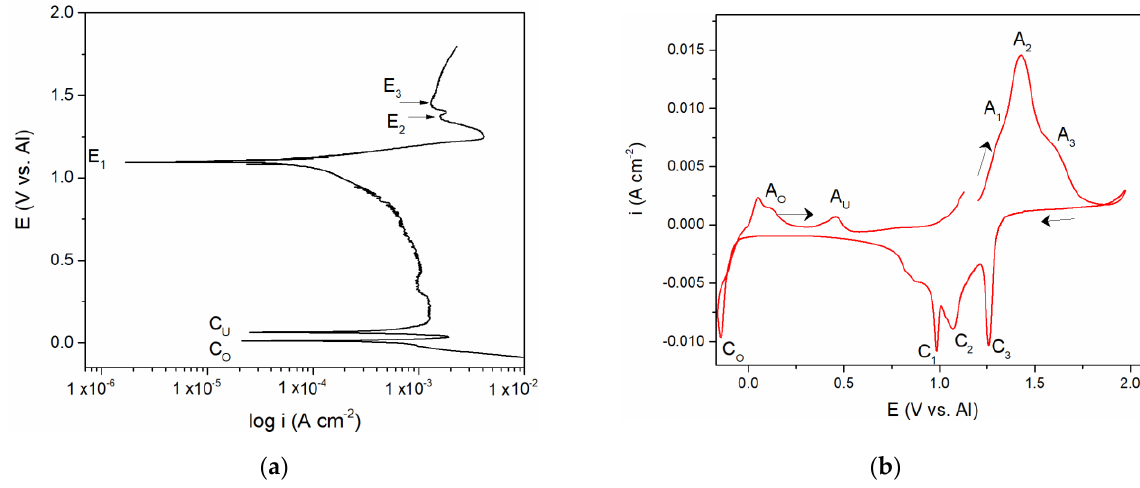
Figure 2. ( a ) Potentiodynamic polarization curve of V working electrode in equimolar melt AlCl 3 + NaCl, T = 200 °C, potential range: ( a ) E I = –0.100 V → E AF = 1.900 V vs. Al v = 1 mVs −1 ; ( b ) voltammogram of vanadium WE in equimolar AlCl 3 + NaCl melt, T = 200 °C, potential change: from E I = 1.200 V to E AF = 2.000 V vs. Al, then to cathodic end potentials of E CF = –0.150 V vs. Al and back to E I , v = 20 mVs −1 .